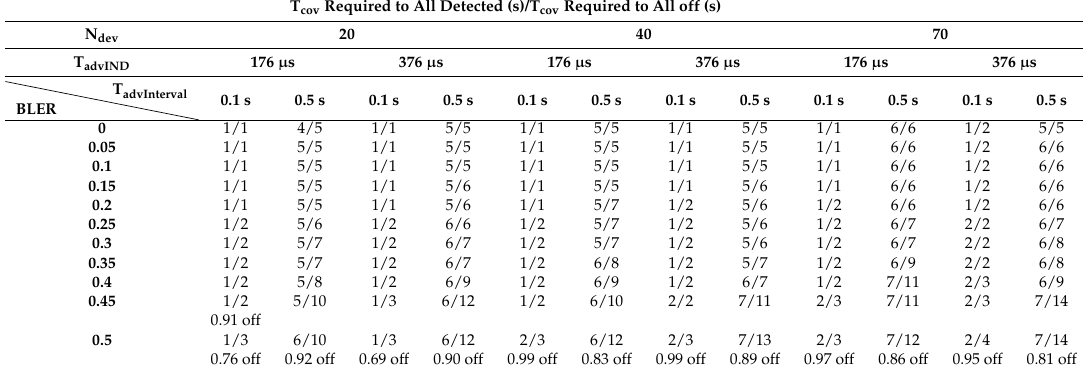
Table 6. Interrupted scannable undirected advertisement scheme . T cov required for detecting and stopping all the devices for two scanners. ((x off) is the probability that all the devices become off in the T cov required to detect all of